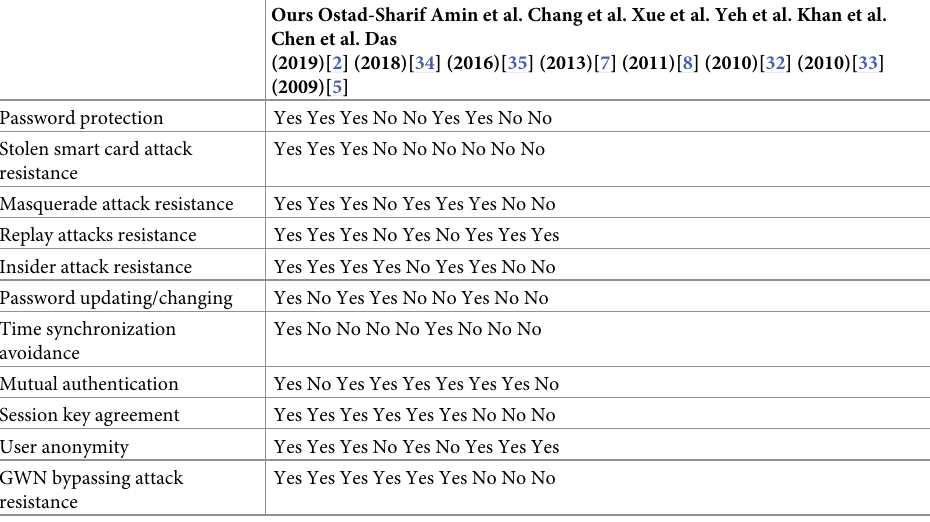
Table 3. Functionality comparison of our scheme with other related